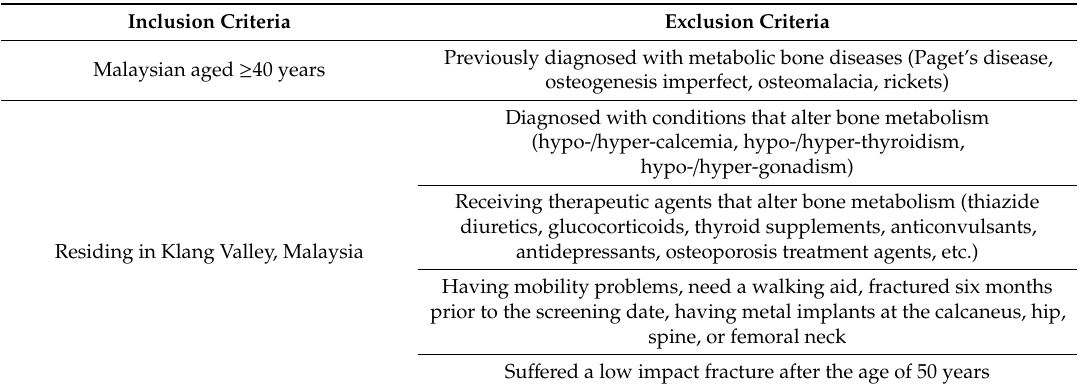
Table 1. Inclusion and exclusion criteria used for this